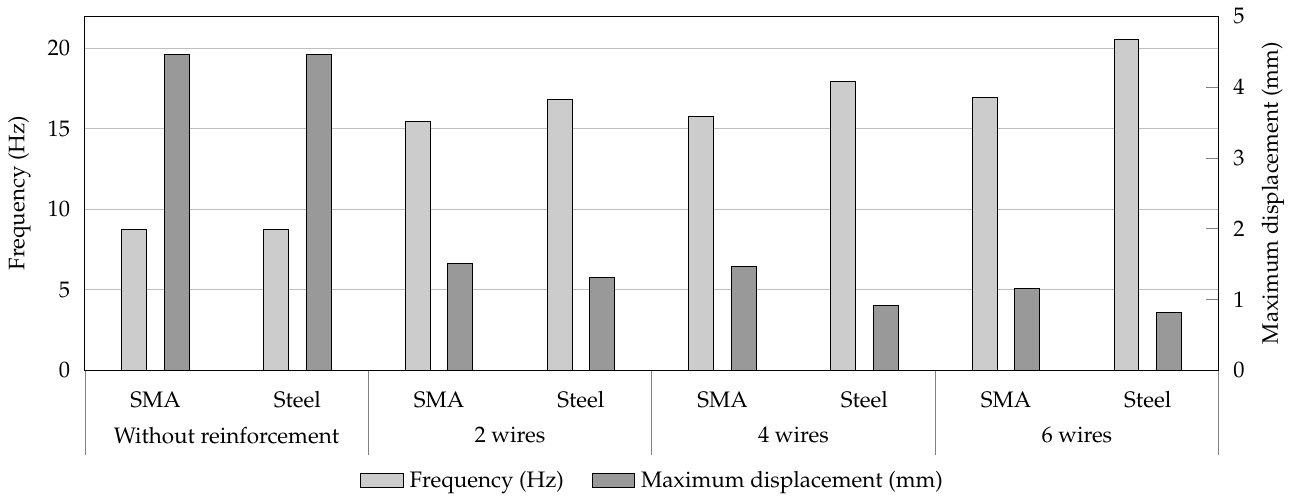
Figure 11. The effect of using SMA or steel with different number of wires on frequencies and maximum displacement of the wall